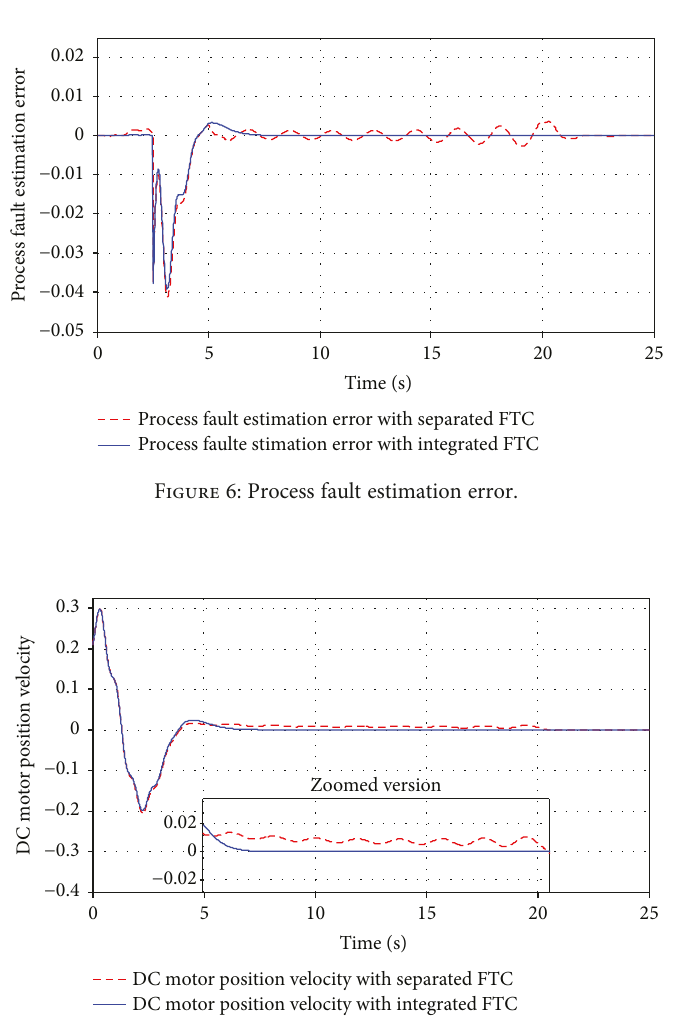
Figure 7: First closed-loop system output response: output response with the separated FE-based FTC (red line) and output response with the integrated FE-based FTC (blue line).